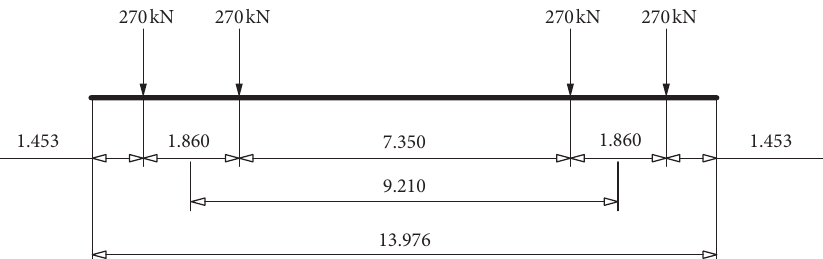
Figure 8: Load diagram of C80E special truck.